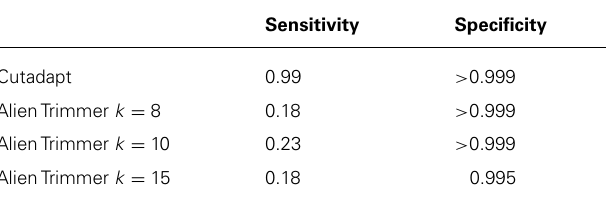
Table 1 | Comparison of the specificity and sensitivity of two adapter trimming